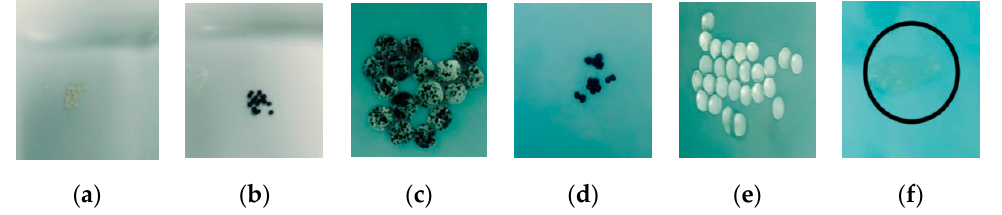
Figure 14. Beads at a dose of 0.025g of adsorbent in a solution with a concentration of 20 ppm of